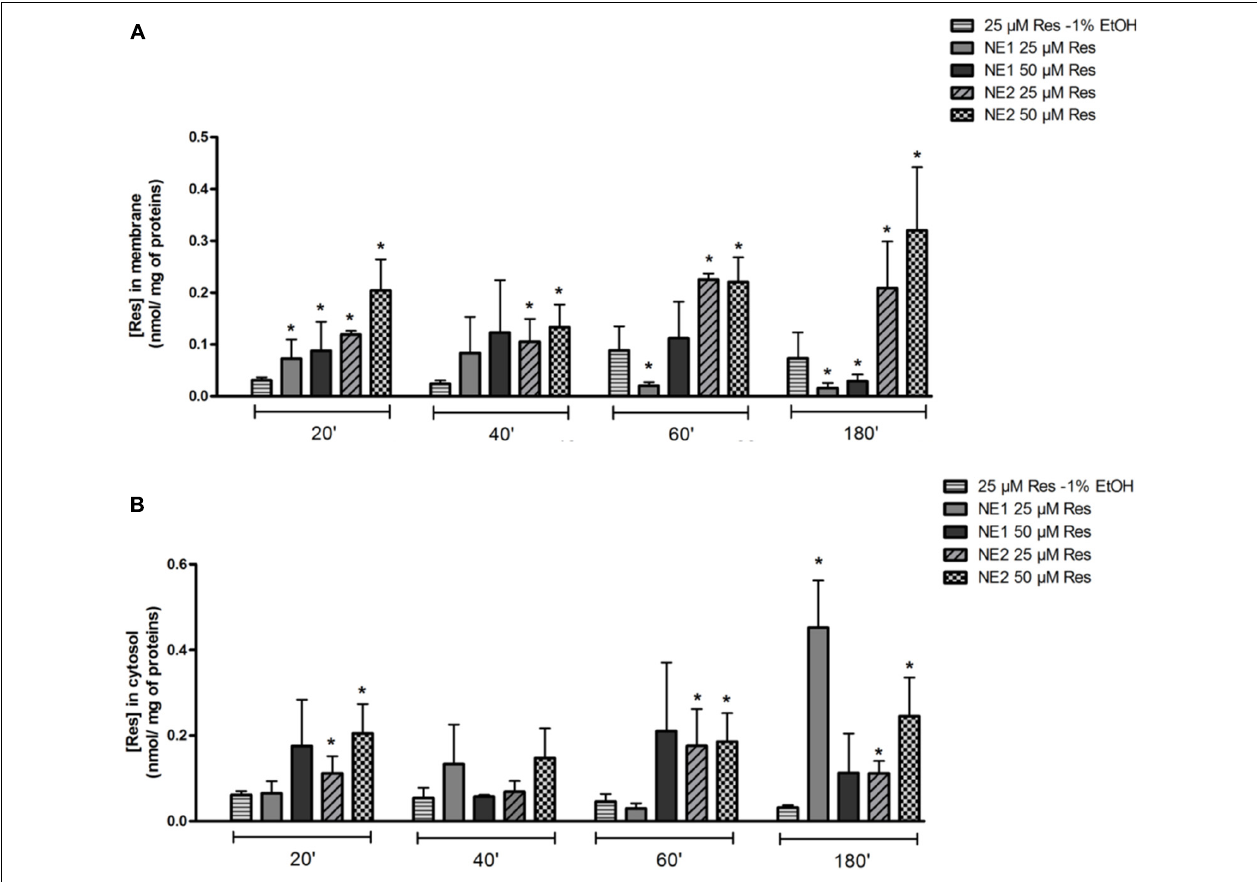
FIGURE 2 | Measurement of resveratrol concentrations in membrane (A) and intra-cellular (B) fractions by HPLC in the chondrocytic cell line T/C28a2. Cells were incubated either with the resveratrol nano-emulsions (25 or 50 µ M) or resveratrol in ethanolic solution (25 µ M) for 20, 40, 60, and 180 min. Results are expressed as mean ± SEM in nmol/mg of protein ( n = 4). ∗ p < 0.05 vs. resveratrol (25 µ M) in ethanolic